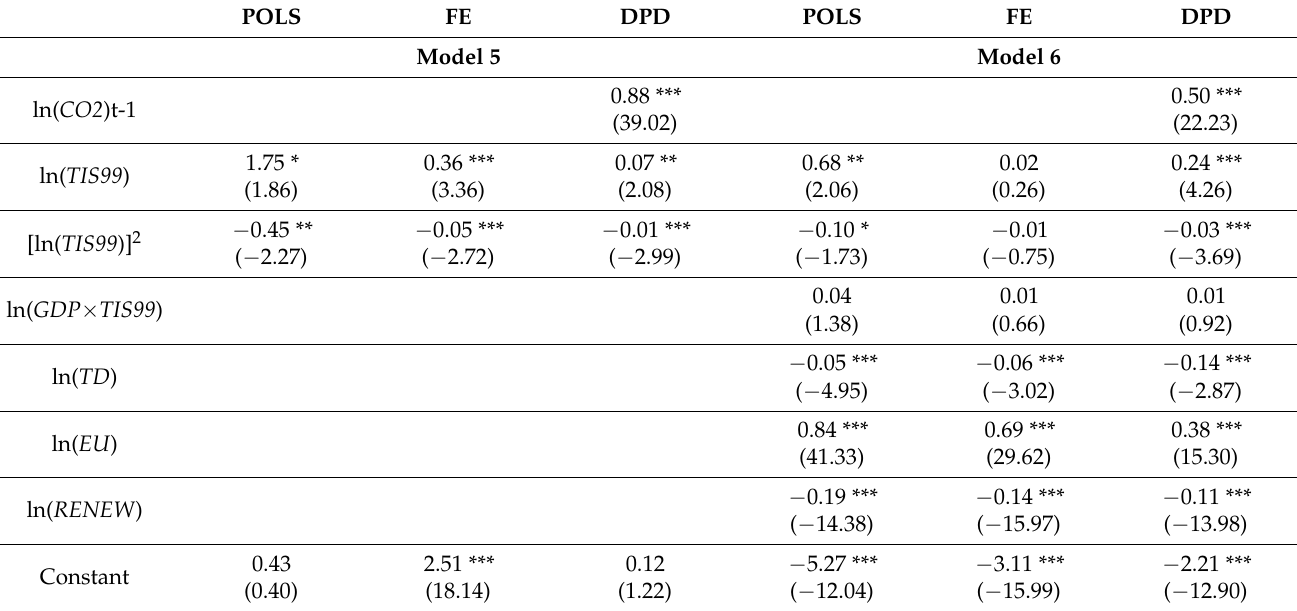
Table 6. The effect of income inequality (measured by top 1% income share) on CO 2